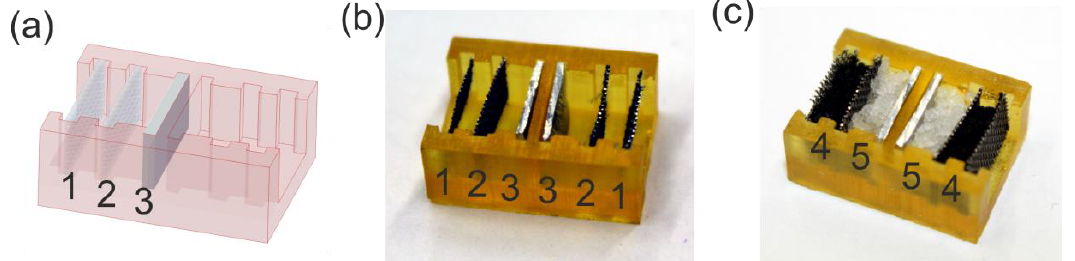
Figure 1. 3D-printed battery with distinct electrolyte chambers. ( a ) Battery design showing two individual battery parts with two platinum-coated meshes (1, 2) and one aluminum sheet (3). ( b ) Printed battery with platinum meshes (1, 2) and aluminum sheets (3). ( c ) Fully assembled battery from ( b ) with additional charcoal (4) and superabsorber/potassium hydroxide filling (5).